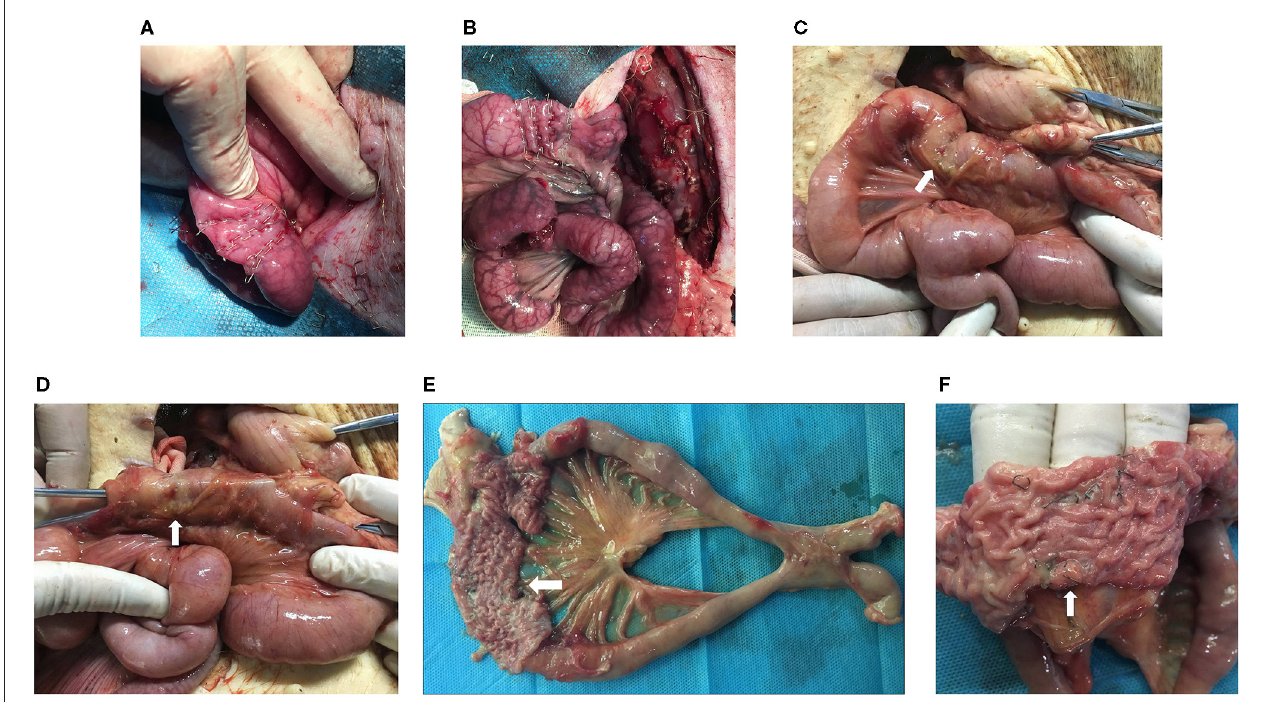
FIGURE 2 | Animal experiments. The intestinal cavity on the afferent limb 3cm from the gastrojejunostomy anastomosis was closed using 6-row linear staplers (A) and 8-row linear staplers (B) . After the pigs were sacrificed, the stapled site (white arrow) showed local indentation and a small amount of adhesion (C) . Recanalization was detected grossly by opening the jejunal loop above the stapled partition (white arrow) (D) . The operative site was harvested, and the stapled intestine (white arrow) was opened (E) . The residual staplers (white arrow) remained in the mucosa (F) .